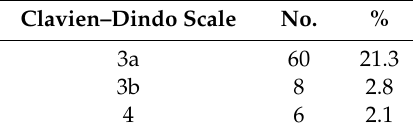
Table 3. Operative